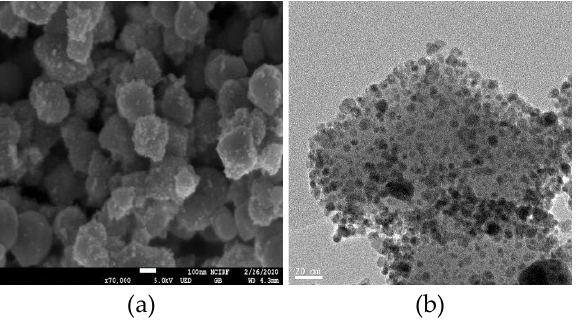
Figure 1. ( a ) SEM and ( b ) HR-TEM image of AuPd – Fe 3 O 4 catalyst.